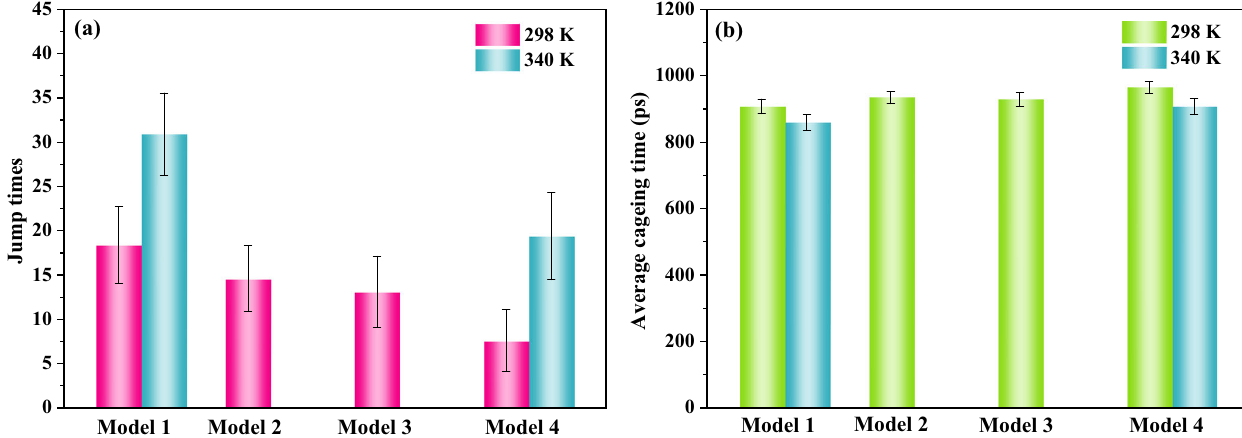
Fig. 12 Jump of H 2 O molecules in different nano-silica/PDMS models at 298 K and 340 K. a Jump times and b average cageing time. The error bars stand for the standard deviations from fi ve independent sample.